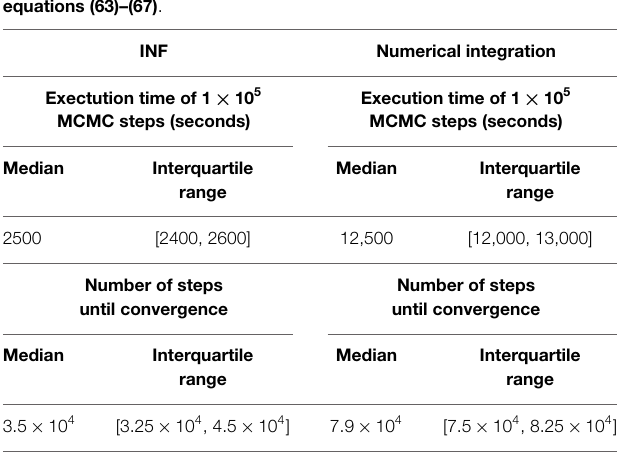
TABLE 2 | Computational times for INF and a method that numerically integrates the ODEs for the protein signaling transduction pathway in equations (63)–(67)